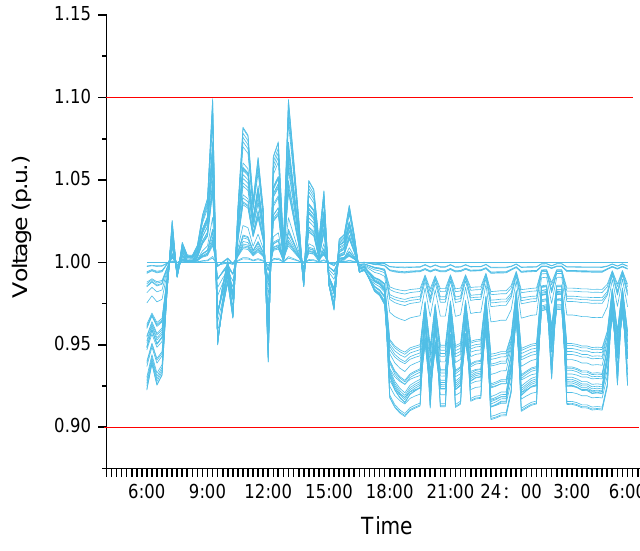
Figure 7. Voltage of 32-node of Case 3.